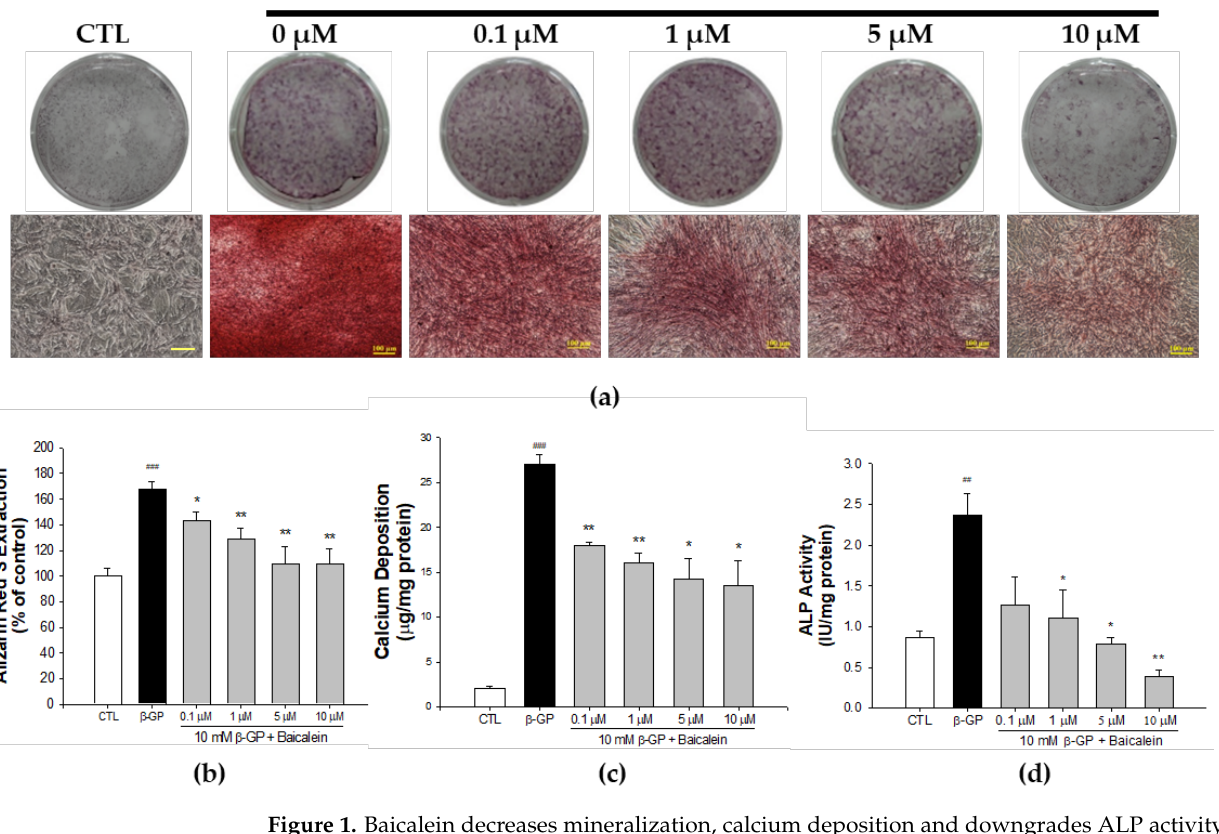
Figure 1. Baicalein decreases mineralization, calcium deposition and downgrades ALP activity in primary rat VSMCs. The cells were cultured with indicated concentrations of baicalein in the presence of β -glycerophosphate ( β -GP)-induced calcification medium for 10 days. ( a ) Calcium nodules were observed under light microscope with Alizarin red S staining. ( b ) Red nodules are calcium deposition in cells culture and represent the amount of calcium. ( c ) In vitro calcium deposition level and ( d ) ALP activity in β -GP-induced primary rat VSMCs. Scale bar indicates 100 μm. All values are presented as mean ± SEM from four independent experiments. ## p < 0.01; ### p < 0.001 vs. control group (untreated VSMCs); * p < 0.05; ** p < 0.01 vs. the β -GP group.